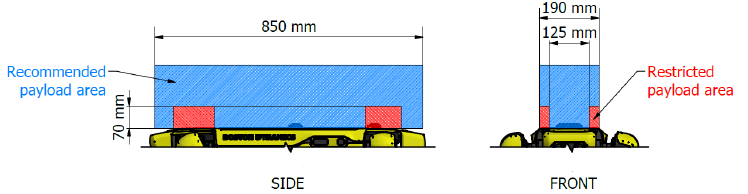
Figure 3. Recommended areas for mounting payloads on Spot